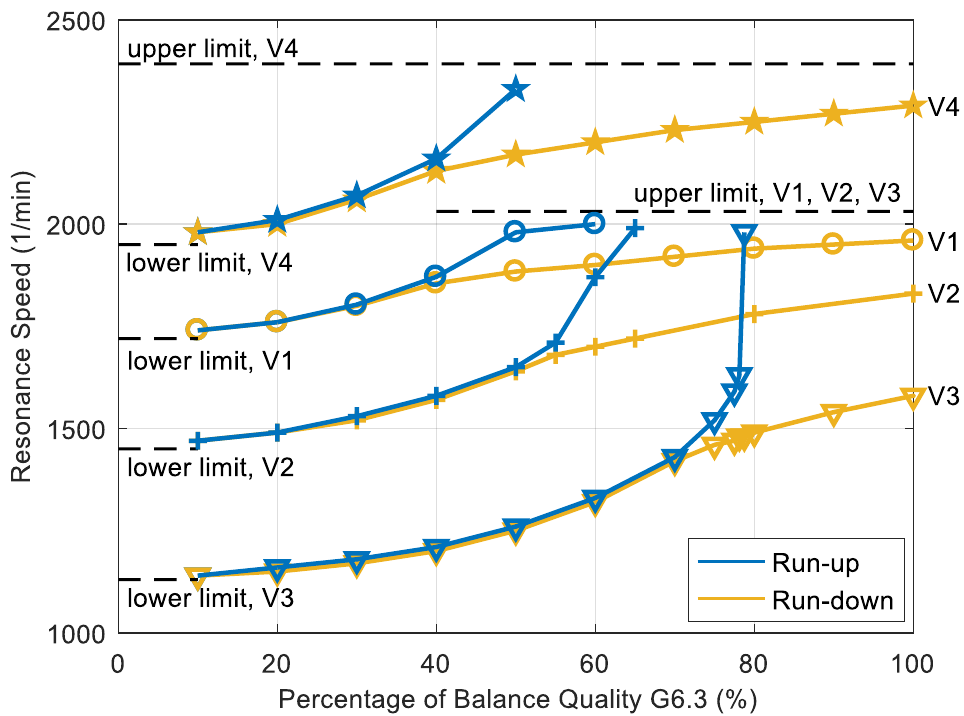
Figure 15. Resonance speed for different bearing variants (Vi) and balance qualities (QLIN).